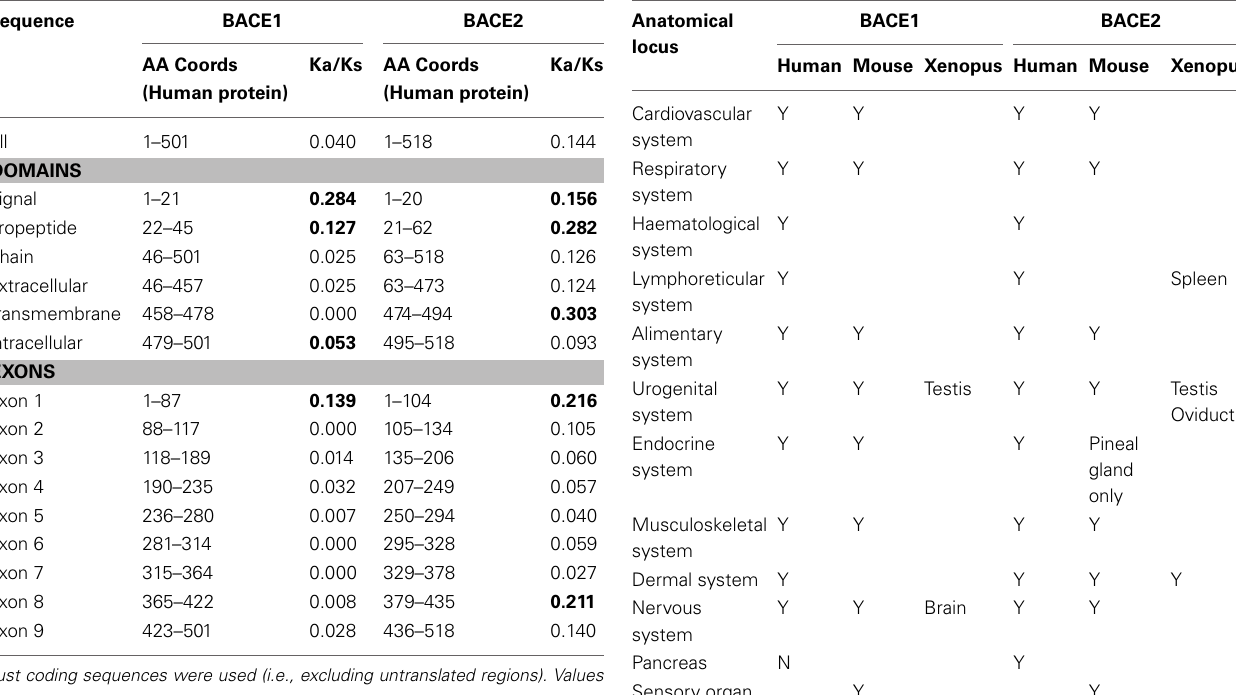
Table 4 | Expression of BACE1 and BACE2 in human, mouse, and